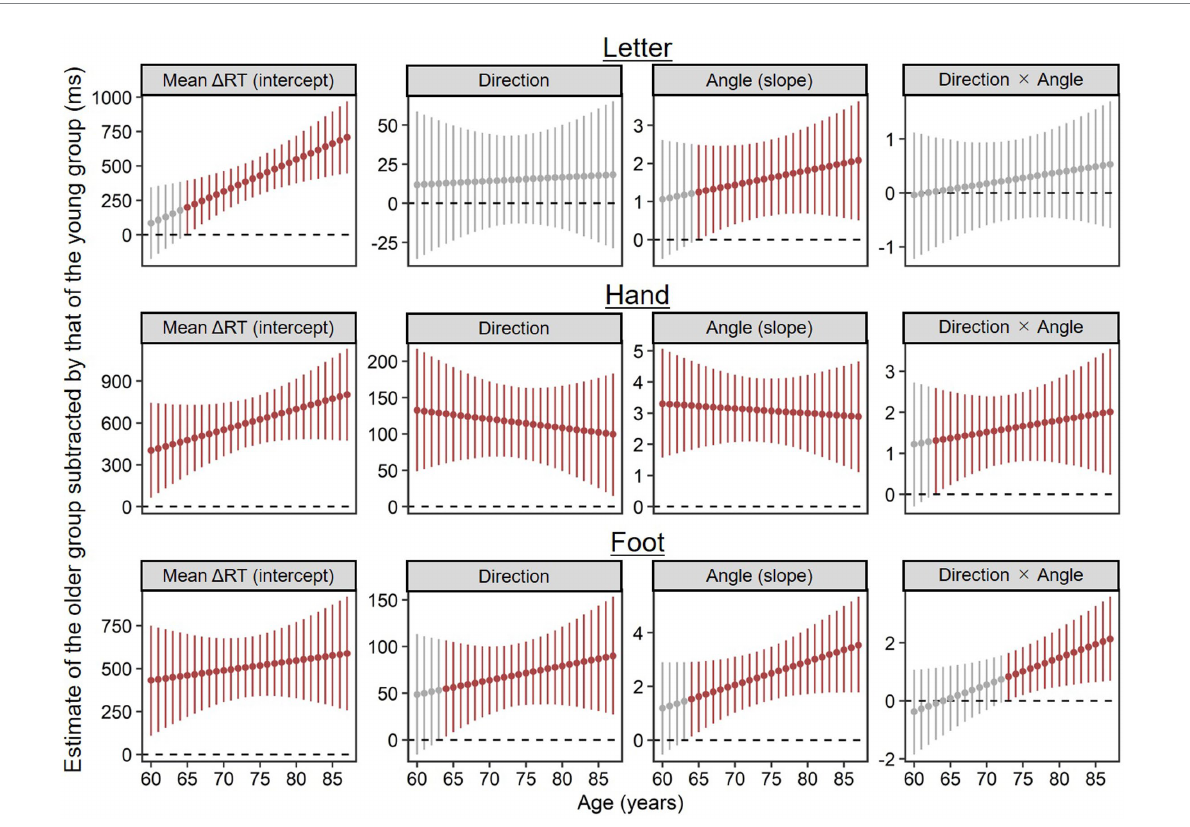
FIGURE 5 Parameter estimates per age of the older group ( n = 71) subtracted by corresponding estimates of the young group ( n = 28), which were calculated using MCMC samples. Higher values indicate stronger contributions for Δ RT relative to the young group. Points and error bars represent estimated means and their 95% credible intervals. Dark red plots show estimates reliably different from the young group’s in the sense that the 95% credible intervals did not include